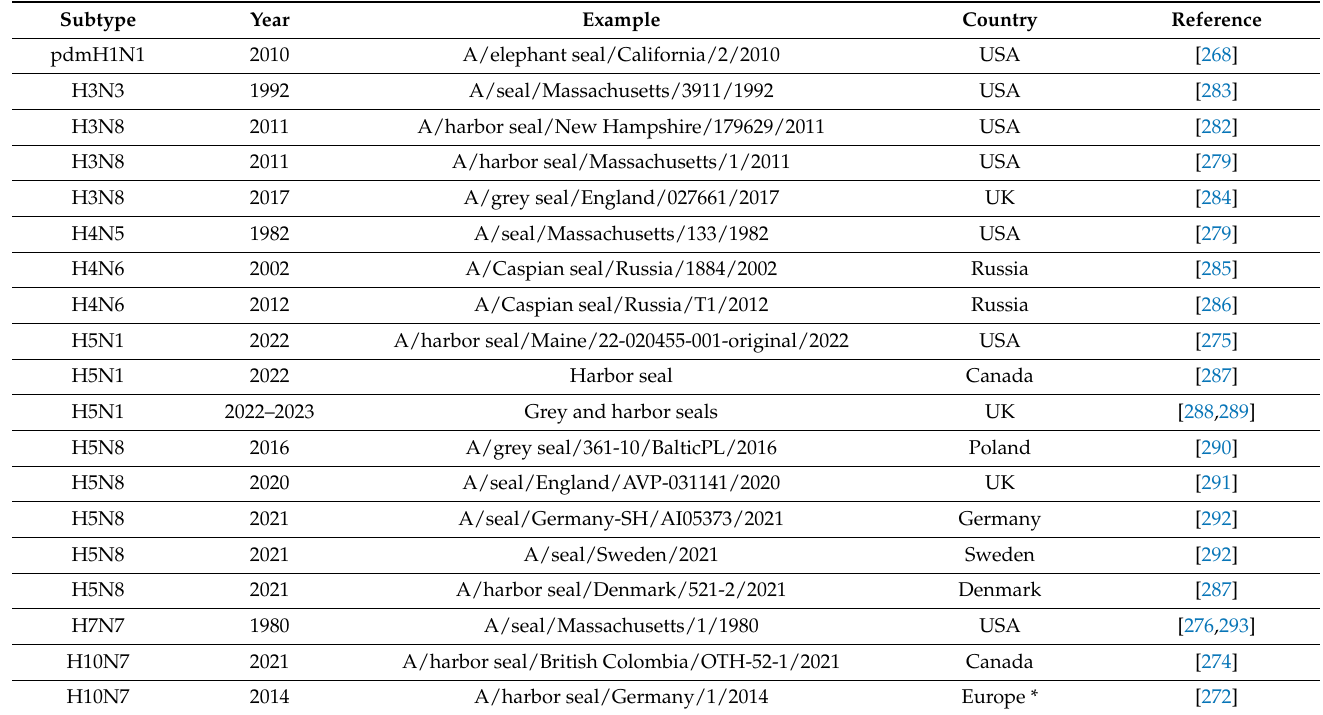
Table 3. Confirmed infections of seals with different influenza viruses from 1979 to